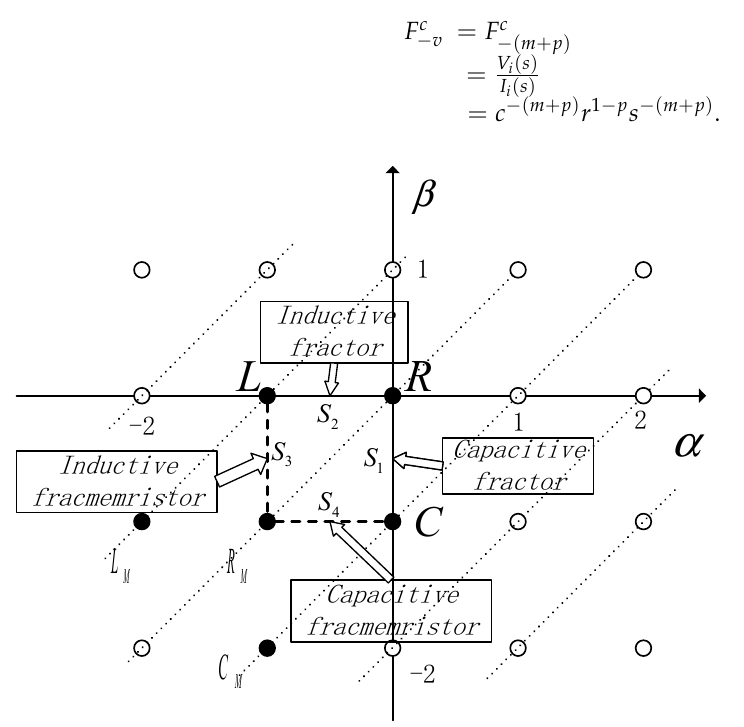
Figure 2. Chua’s periodic table of all two-terminal circuit elements.